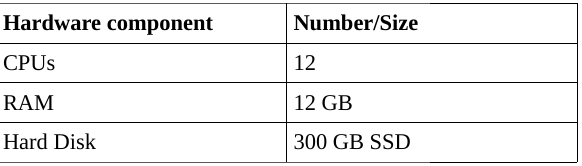
Table 1. Virtual machines hardware characteristics.